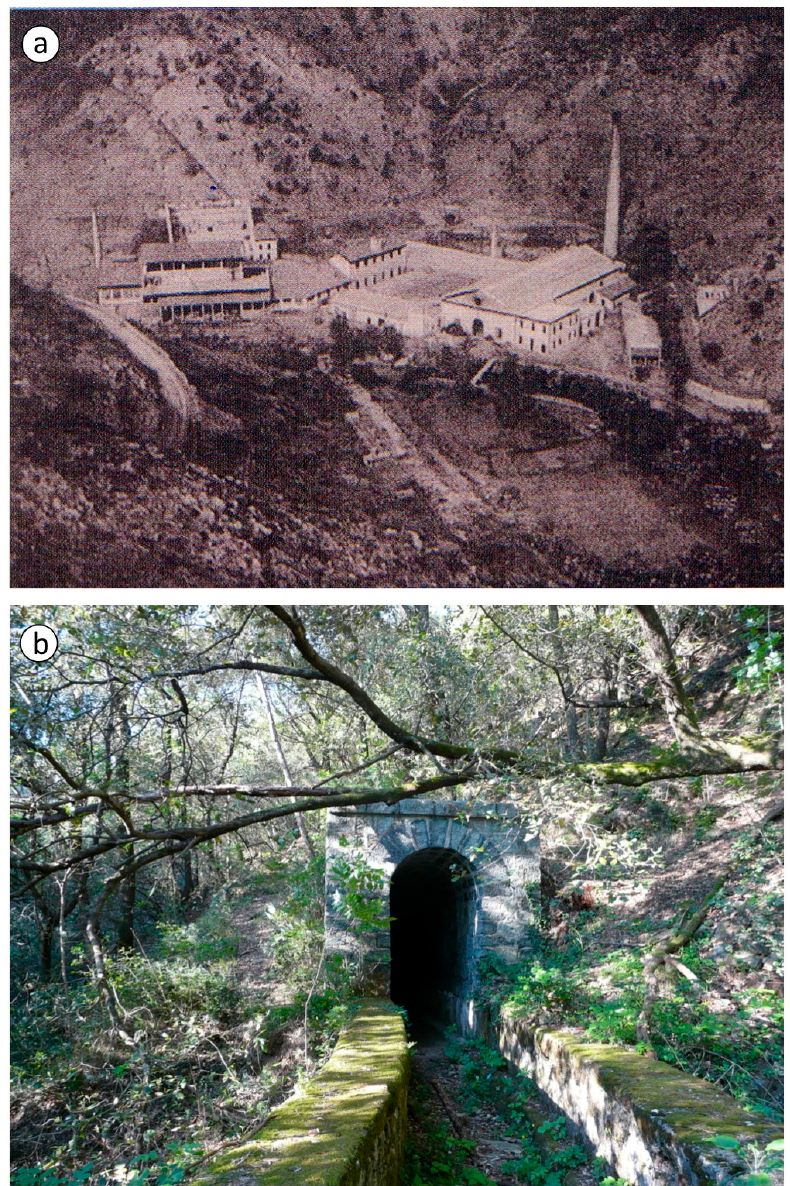
Figure 3. ( a ) Historical photograph (1920) of the “Molino del Bargonasco” plant (photo by courtesy and with the permission of Mr. Angelo Perrone); ( b ) recent photograph (2016) of the tunnel adit in the water catchment channel of the Bargonasco valley.